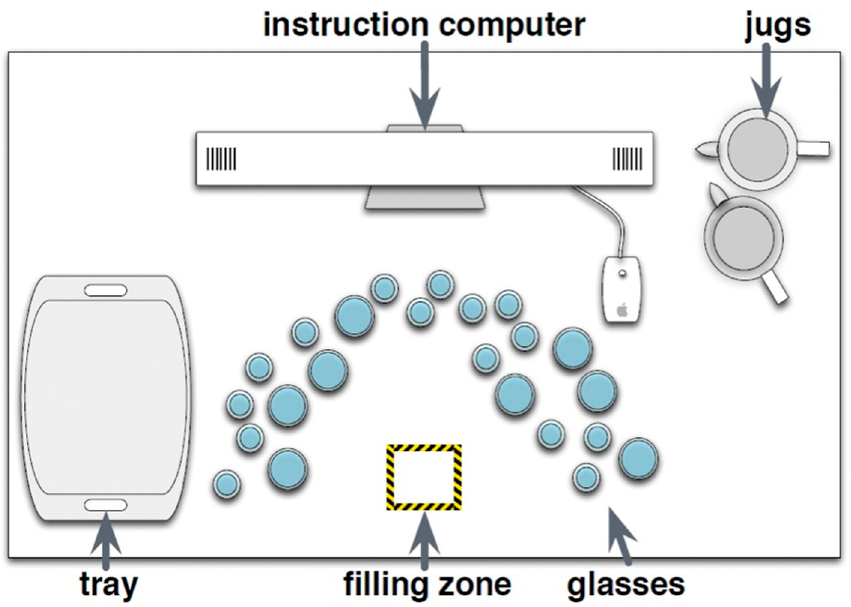
Figure 1. Experimental layout of workspace.